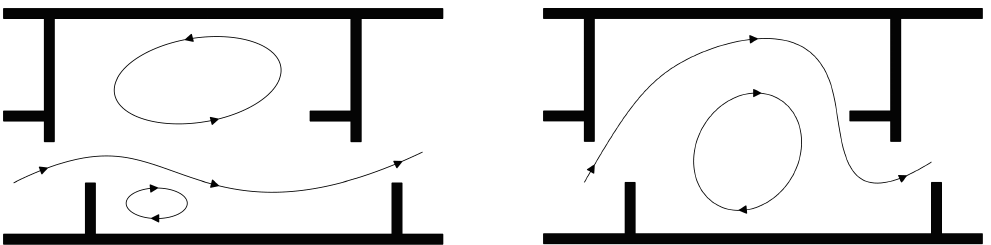
Figure 2. Flow patterns in a VSF based on [5], ( left: ) flow pattern 1, ( right: ) flow pattern